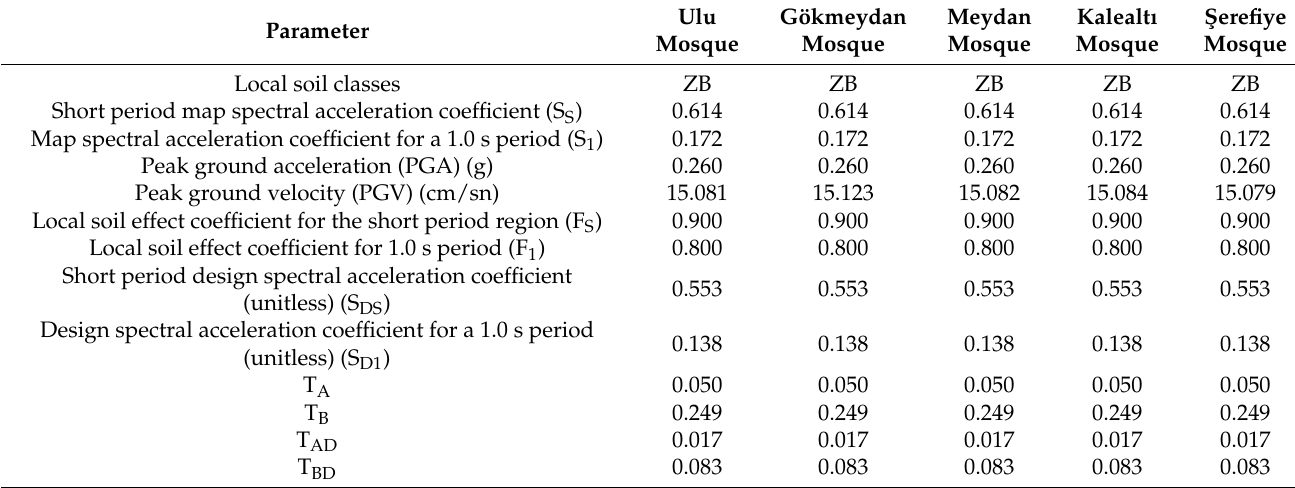
Table 3. The seismic parameters obtained for Five Minarets.